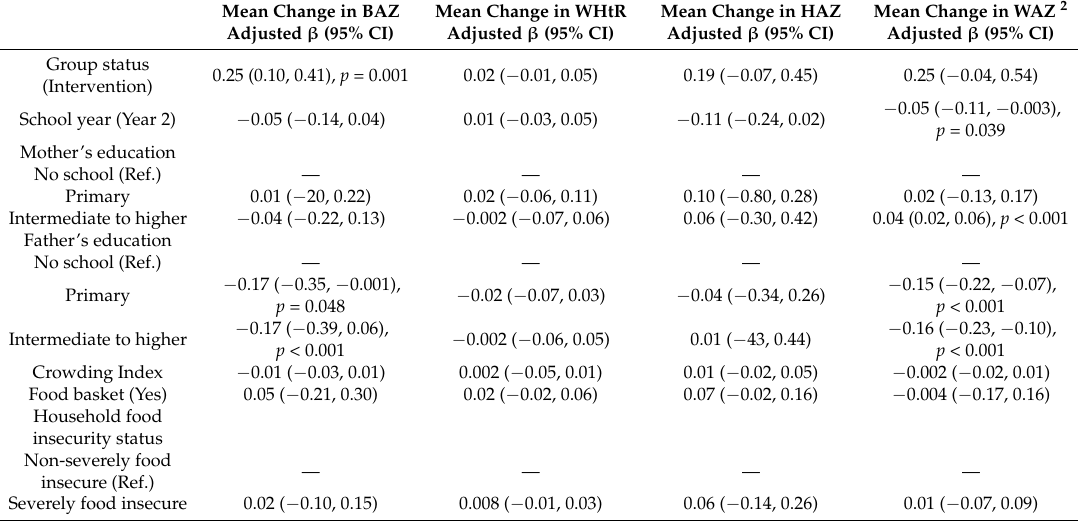
Table 4. General linear regression models for mean change in anthropometric measurements (BAZ, WHtR, HAZ, and WAZ) among school-aged children in the study sample 1 ( n = 183). Mean Change in BAZ Mean Change in WHtR Mean Change in HAZ Mean Change in WAZ 2 Adjusted β (95% CI) Adjusted β (95% CI) Adjusted β (95% CI) Adjusted β (95%